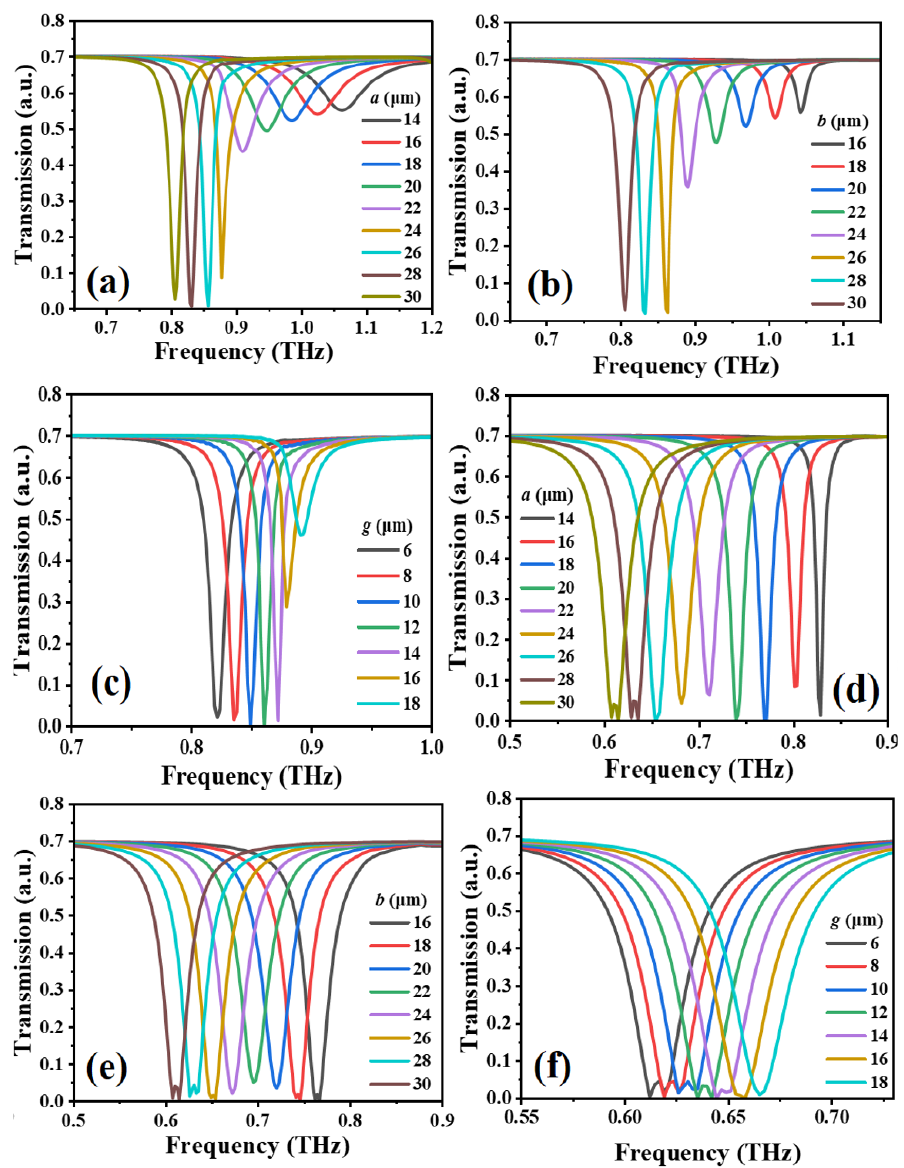
Figure 2 Figure 2. Transmission spectra of MTM with different ( a , d ) a , ( b , e ) b , ( c , f ) g values in ( a – c ) TM and ( d – f ) TE